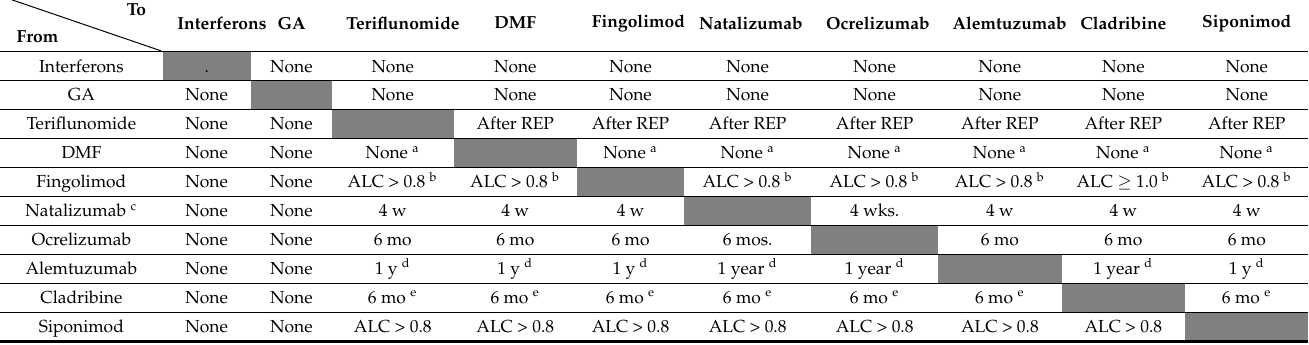
Table 4. Washout period for switching between disease-modifying